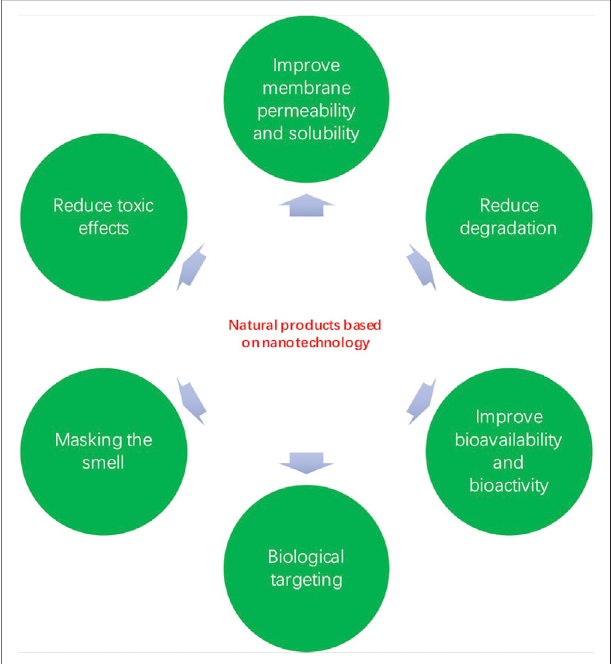
FIGURE 2 | Natural products based on